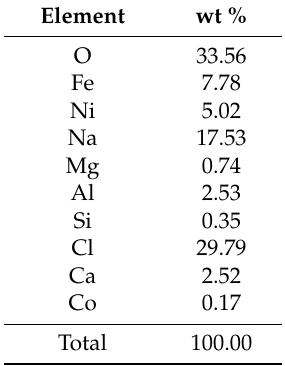
Table 3. Energy Dispersive Spectroscopy (EDS) analysis of effluent samples collected during carbonated water flooding into Bentheimer